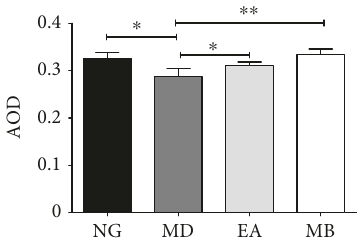
Figure 8: The average optical density (AOD) of CRH in the hypothalamus. The results ( n = 8 /group) showed that the AOD of hypothalamic CRH expression in the MD group was signi fi cantly reduced (vs. NG group, P < 0 05 ), but that in both the EA and the MB groups was signi fi cantly enhanced (vs. MD group; ∗ P < 0 05 and ∗∗ P < 0 01 ). CRH: corticotropin-releasing hormone. NG: normal group; MD: model group; EA: electroacupuncture group; MB: moxibustion